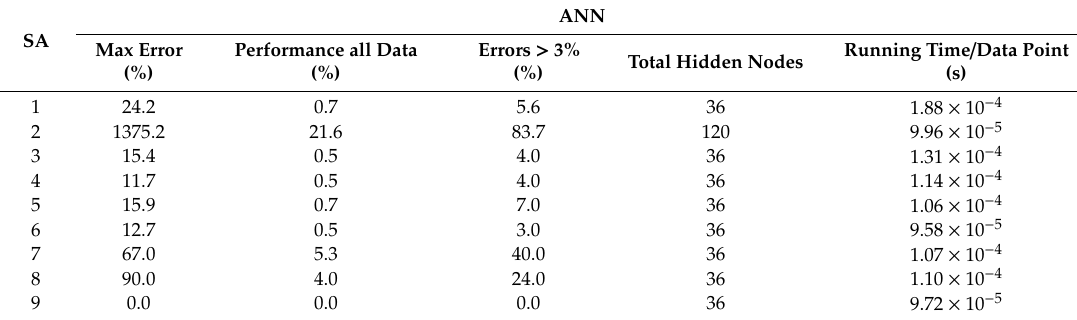
Table 7. For each SA: performance results of best net.